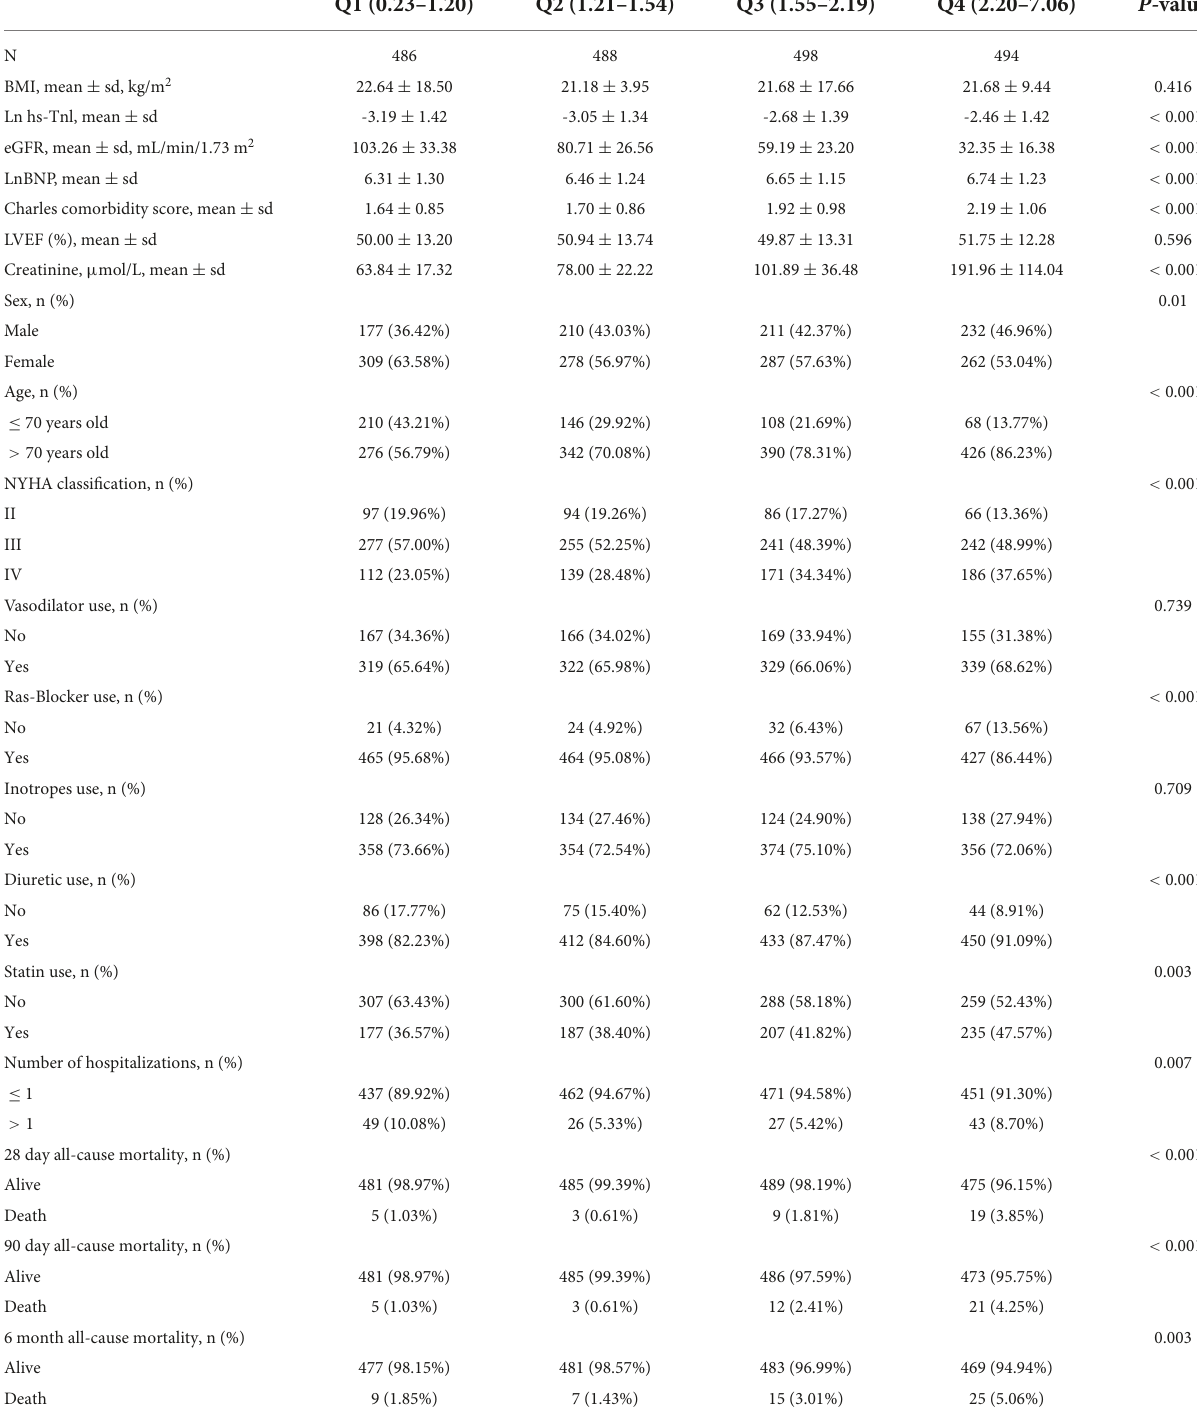
TABLE 1 Baseline characteristics of patients with heart failure grouped by cystatin